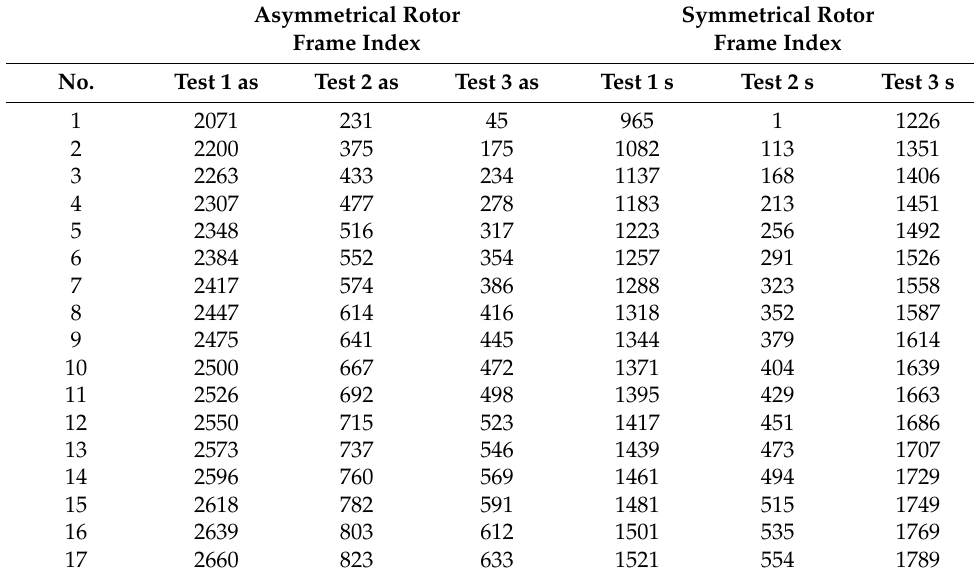
Table 3. Experimental data for finding the rolling angle of the